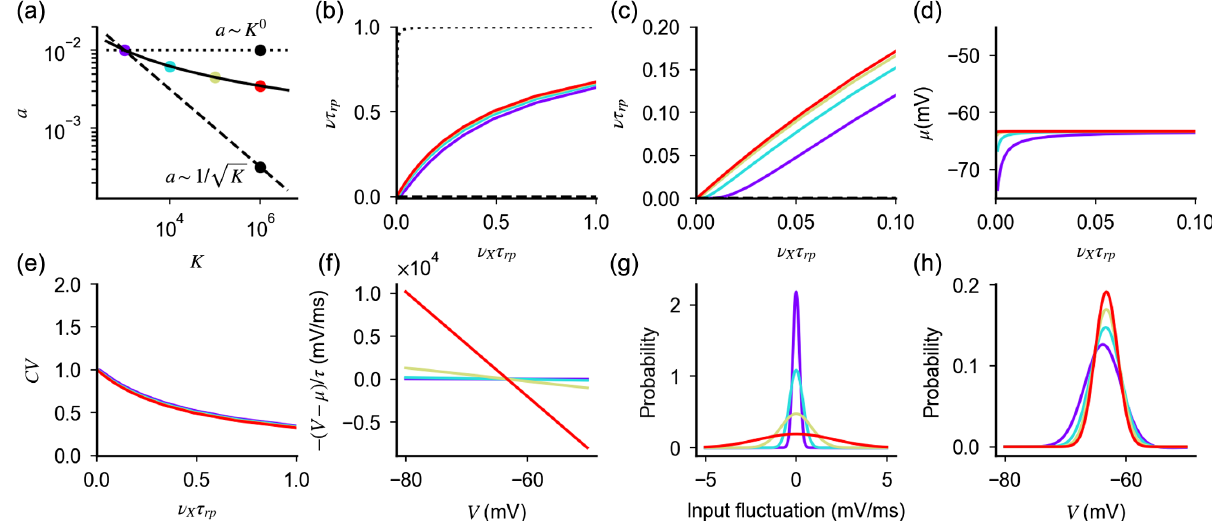
FIG. 2. The scaling of Eq. (14) preserves the response of a single conductance-based neuron for large K . (a) The scaling relation preserving firing in conductance-based neurons [Eq. (14), solid line]; constant scaling ( a ∼ K 0 , dotted line) and scaling of the balanced ffiffiffiffi p K state model ( a ∼ 1 = , dashed line) are shown as a comparison. Colored dots indicate values of a and K used subsequently. (b) – (h) Response of conductance-based neurons, for different values of the coupling strength and synaptic efficacy (colored lines). The scaling of Eq. (14) preserves how the firing rate (b),(c), equilibrium value of the membrane potential (d), and CV of the interspike interval distribution (e) depend on external input rate ν . This invariance is achieved by increasing the drift force (f) and input fluctuation (g) in a X way that weakly decreases (logarithmically in K ) membrane potential fluctuations (h). Different scalings either saturate or suppress the response [(b); black lines correspond to K ¼ 10 5 and a values as in (a)]. Parameters: a ¼ 0 . 01 for K ¼ 10 3 , g ¼ 12 , η ¼ 1 . 8 , and γ ¼ 1 = 4